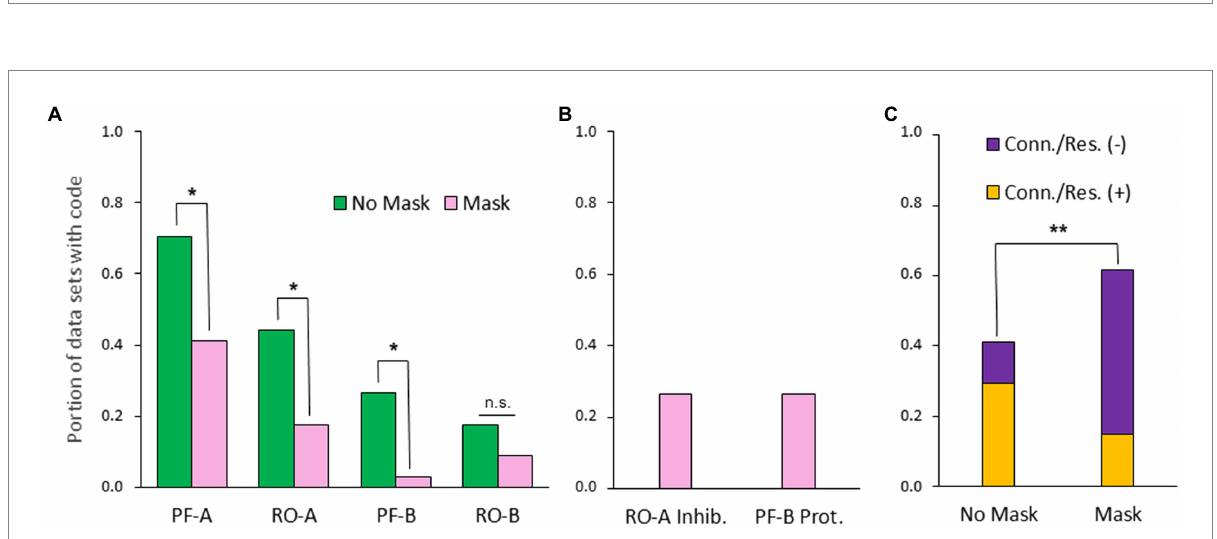
FIGURE 5 Level 3: Micro-activities. (A) The four micro-activities (PF: Proactive-focused, RO: Receptive-opening), reordered by size, * p < 0.019, n.s., not significant, p > 0.39. (B) Negative aspects related to micro-activities (inhibition, protection, only mask cond.); (C) Connection/Resonance (+/ − ), ** p =